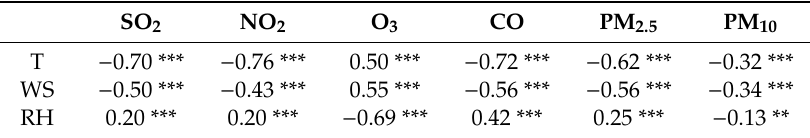
Table 5. Correlations between six criteria air pollutants and meteorological parameters (T—temperature; WS—wind speed; RH—relative humidity) in Spearman’s correlation coe ffi cient. Daily measurements were used for calculation. Strong correlation: | ρ | > 0.5; Moderate correlation, 0.3 < | ρ | < 0.5; Weak correlation, | ρ | ≤ 0.3. Number of stars represent significant levels. (*** p -value < 0.001; ** p -value < 0.05; * p -value <